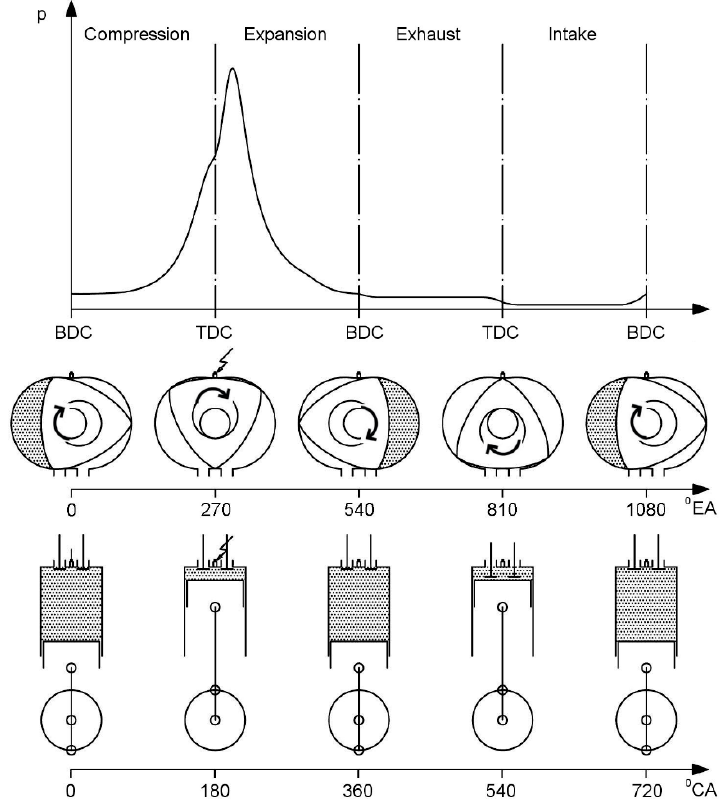
Figure 1. Four-stroke cycle for reciprocating and Wankel engines.